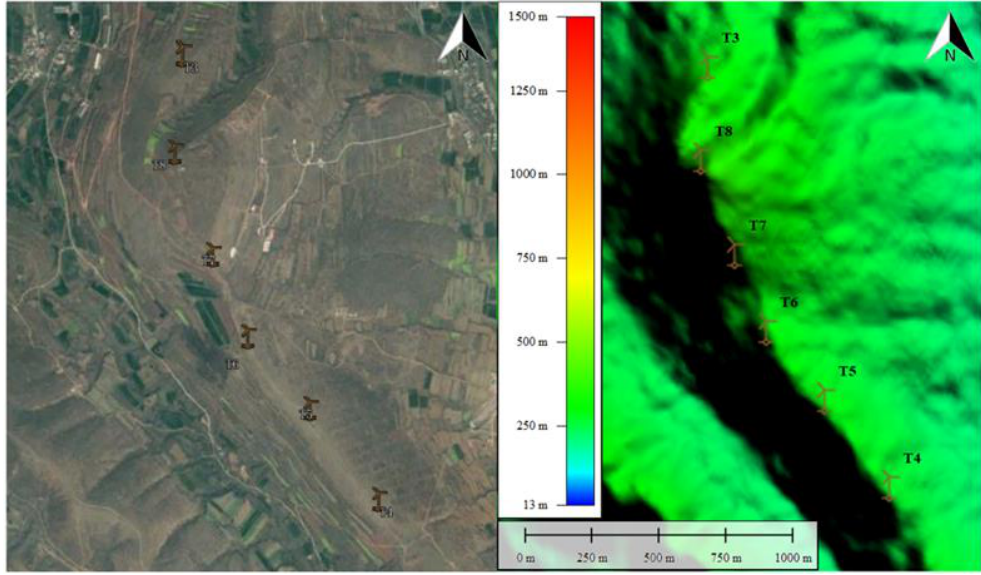
Table 3. The influence sector of upstream wind turbine on downstream wind turbine.